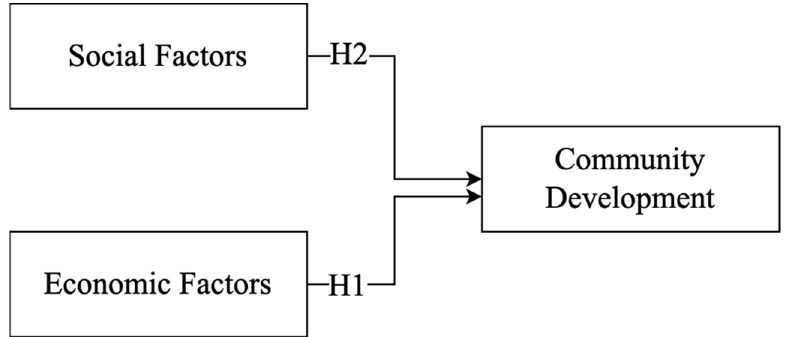
Figure 1. Conceptual model of the study.